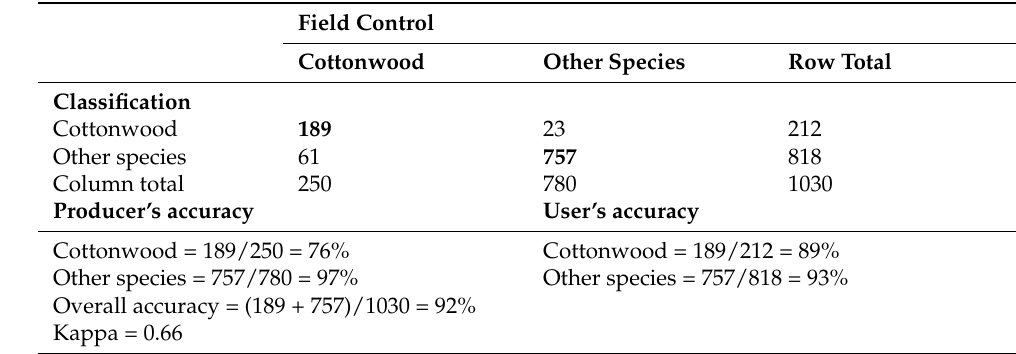
Table 11. Confusion matrix for cottonwood trees based on the Dalponte2016 segmentation model. Species were modeled using canopy steepness and variation in canopy steepness. Segments were classified using a logistic generalized linear mixed model with a plot held as a random effect.